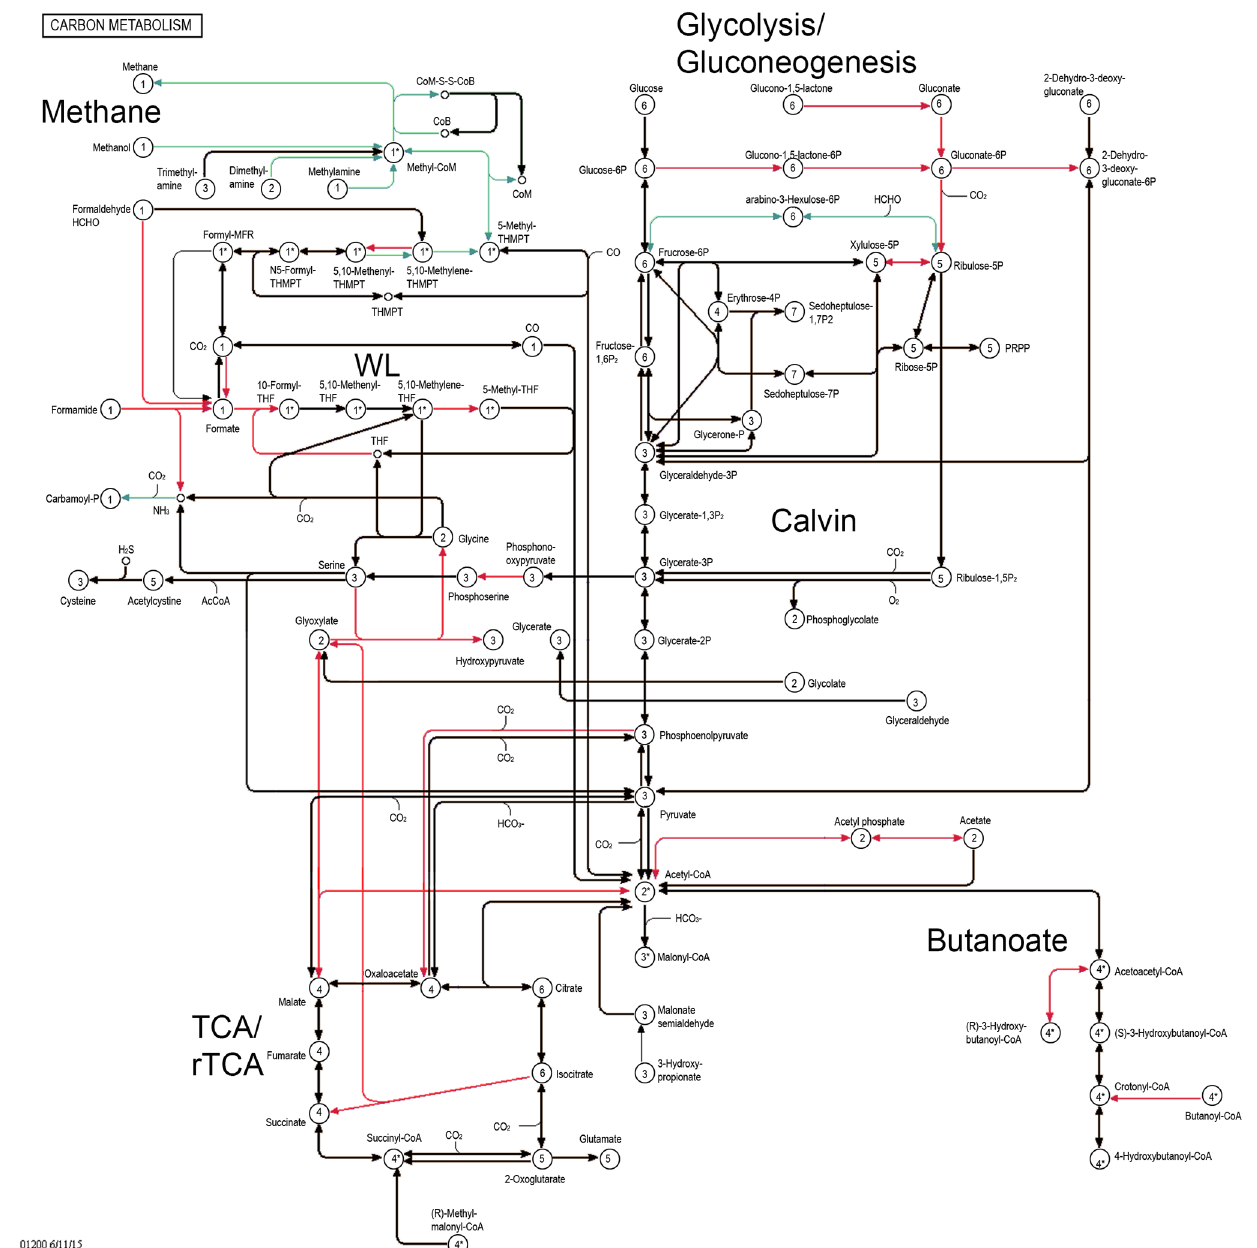
Figure 8. The microbial carbon metabolism pathway according to KEGG. The predicted genes combined from all samples were plotted on the map. Green arrows indicate enzymes predicted only in the archaeal communities, red arrows indicate genes predicted only in the bacterial communities, and black arrows show enzymes predicted in both the archaeal and bacterial